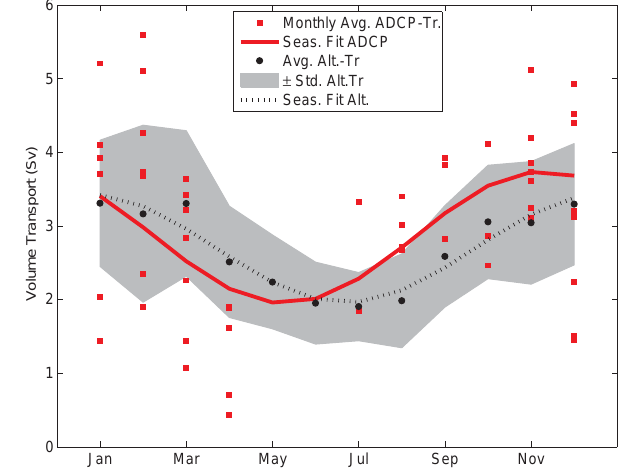
Fig. 9. Monthly mean net volume transport above the 5 ◦ C isotherm through the FSC plotted against month. Red rectangles indicate in- dividual monthly mean ADCP transport, solid red line shows sinu- soidal fit for this data ( R 2 = 0 . 21). Black circles indicate average transport for each month based on the full Altimetry transport se- ries, and the grey area surrounding it indicates ± the standard devi- ation. The dotted black line shows the best sinusoidal fit to the full Altimetry-transport series ( R 2 = 0 .